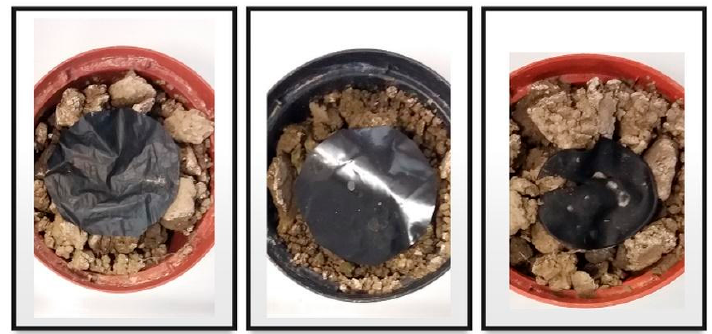
Figure 2. Representative films after ten days of mulching (left to right): Mater-Bi, polyethylene, the innovative protein-based film.